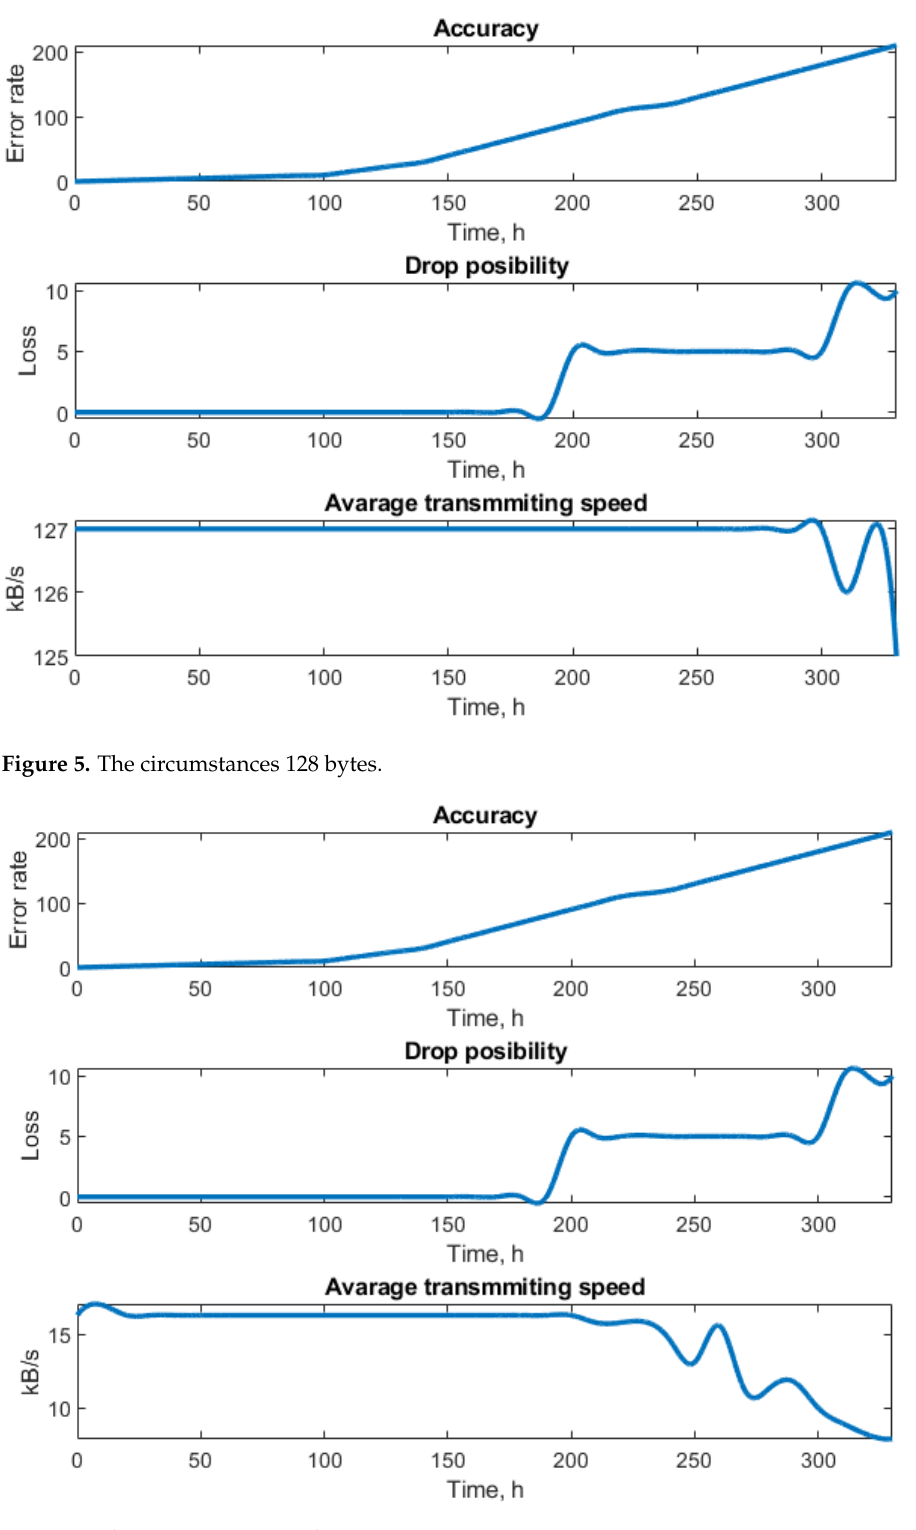
Figure 6. The circumstances 16